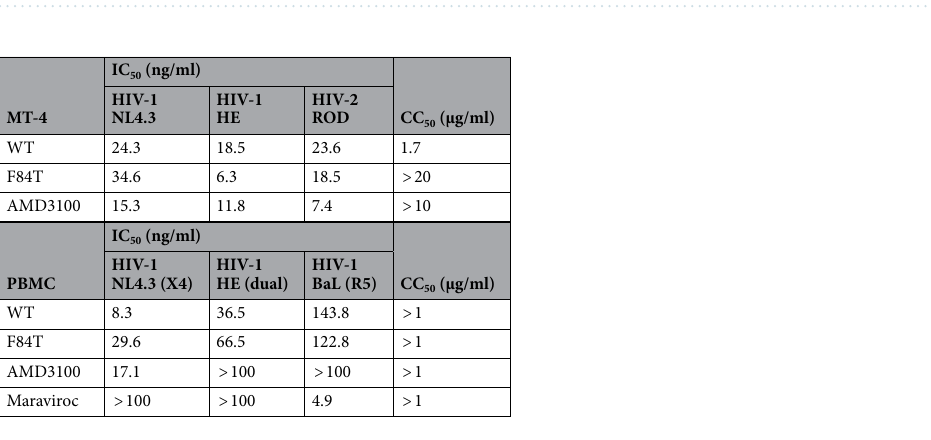
Table 3. Inhibition of multiple strains of HIV by F84T versus WT Malay BanLec. CC 50 , 50% cytotoxic concentration.